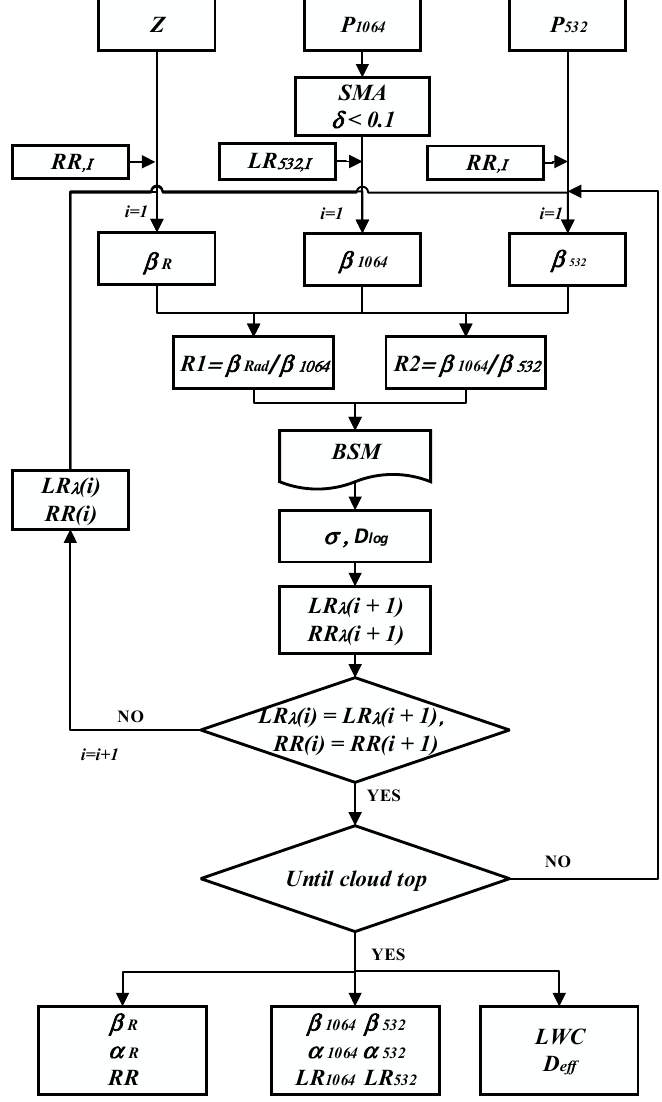
Figure 1. Schematic of the algorithm for the retrieval of optical and microphysical properties of clouds by multiwavelength lidar and cloud radar.